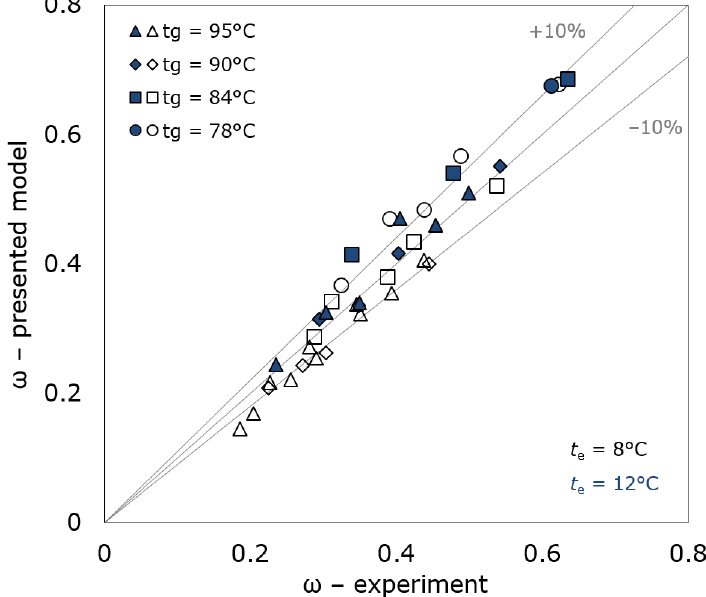
Figure 4. Comparison of the experimental data presented in [42] and the model performed by the authors.